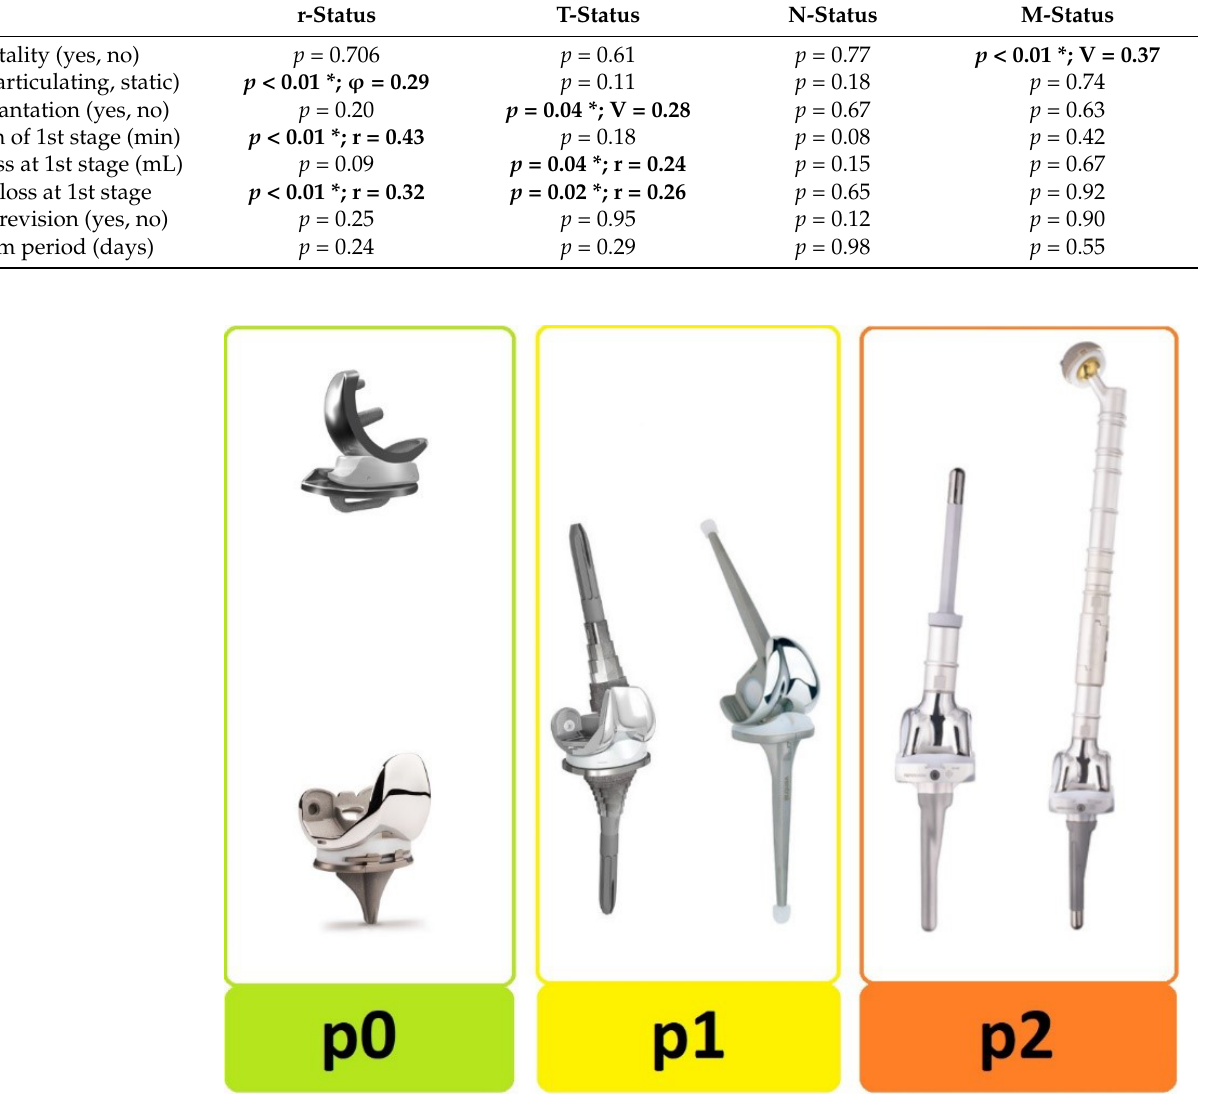
Figure 1. Type of infected prosthesis at time of diagnosis . The “p - status” distinguishes between : p0 = standard implant, p1 = revision implant, and p2 = megaprosthesis.